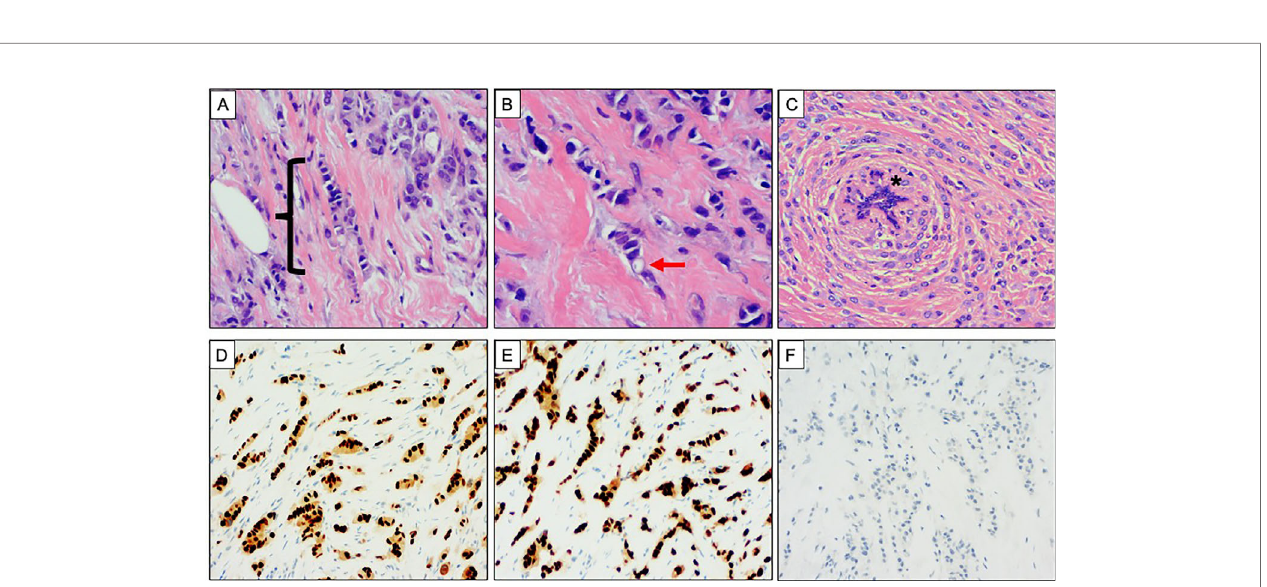
FIGURE 2 | Classical morphology and immunophenotype of invasive lobular carcinoma. (A – C) Haematoxylin and Eosin stained sections demonstrating the classical morphology of invasive lobular carcinoma (ILC). (A) Single fi le pattern of invasion, highlighted with bracket ({}. (B) High power view showing discohesive tumor cells. An intracytoplasmic vacuole is highlighted with the red arrow. (C) Concentric pattern of in fi ltration around a normal breast duct, highlighted with asterisk (*). (D – F) Classical immunophenotype of ILC. Strong and diffuse nuclear expression of (D) oestrogen receptor and (E) progesterone receptor. (F) Absence of membranous E Cadherin